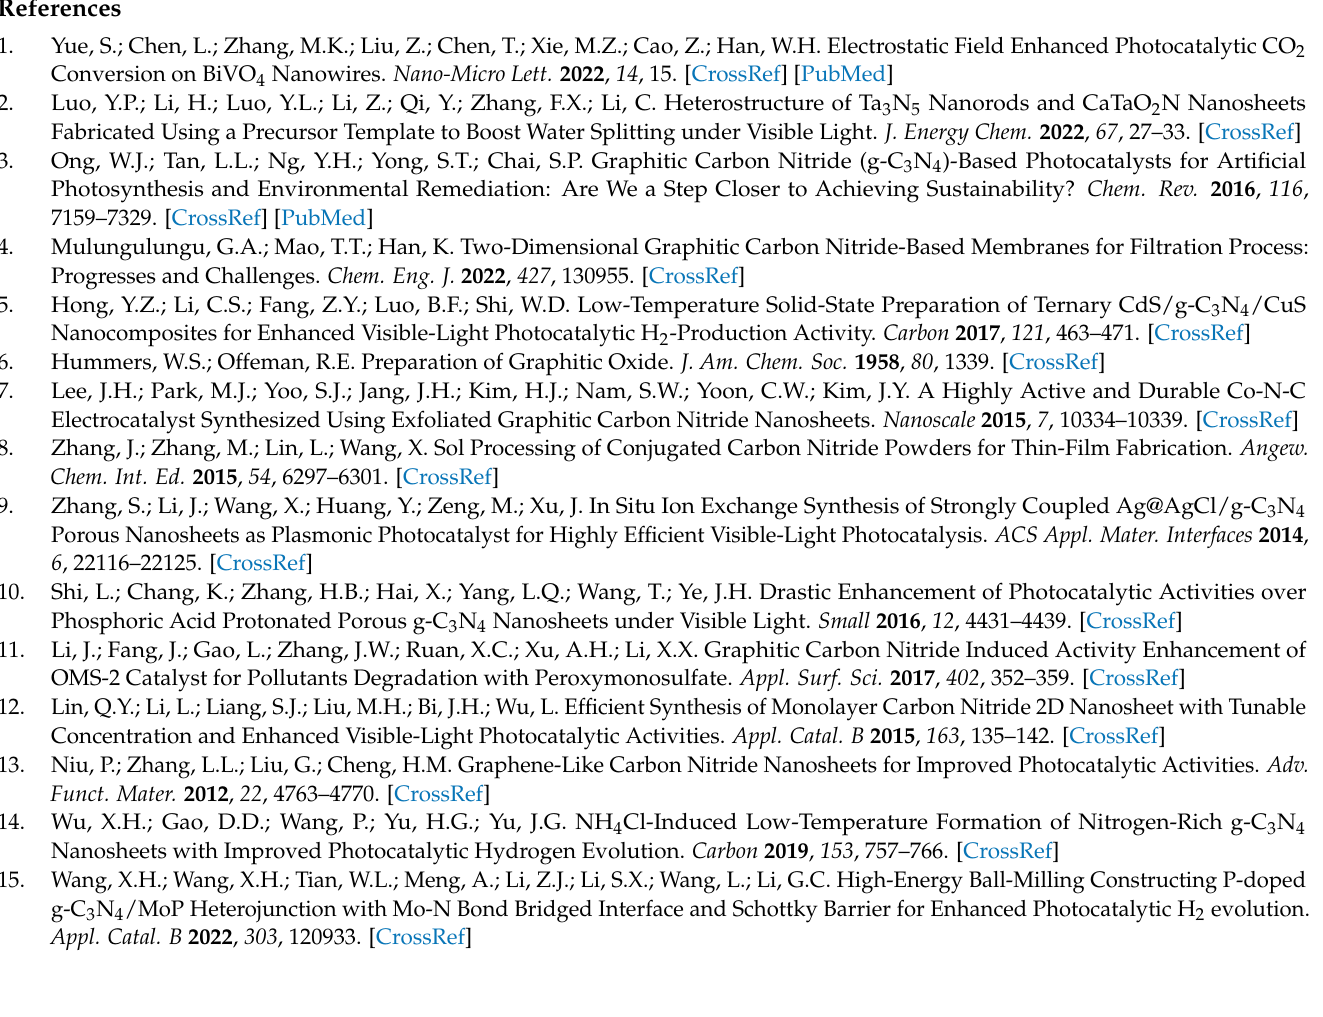
4. Figure S3: TG curves of bulk g-C3N4 and the precursors to prepare the different exfoliated g-C3N4/MoO2 composites. Figure S4: Valence-band XPS spectrum (a) and Motto-Schottky plot (b) of the optimal sample CNM-4. Valence-band XPS spectrum (c) and Motto-Schottky plot (d) of MoO 2 . (e) ( α h ν ) 2 versus Eg plot of MoO 2